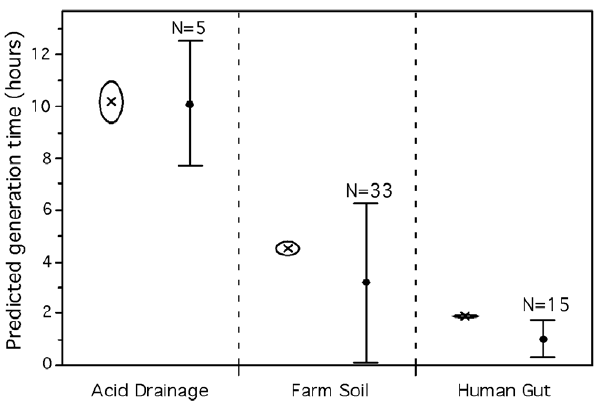
Figure 7. Average predicted minimum generation time for 3 environmental metagenomes. Crosses represent the average for the whole metagenome approach while dots represent the average for the pseudo-genome approach. All predictions were calculated with the predictor for mesophilic organisms (eq. 3). The average minimum generation time of the whole metagenome (crosses) and the respective standard deviation (open circles) were generated with 1,000 bootstraps on the dataset of all genes and highly expressed genes independently. The 3 whole-metagenome datasets are all significantly different (p- value , 0.001). Minimum generation times were calculated using the whole genome of the sequenced genomes matching proteins of the metagenome (see Materials and Methods: classification of metagen- omes into pseudo-genomes). The number of matching sequenced genomes are given above the average (dots) and standard deviation (bars) of the predictions. The 3 pseudo-genomes datasets are all significantly different (Tukey-Kramer: p-value ,